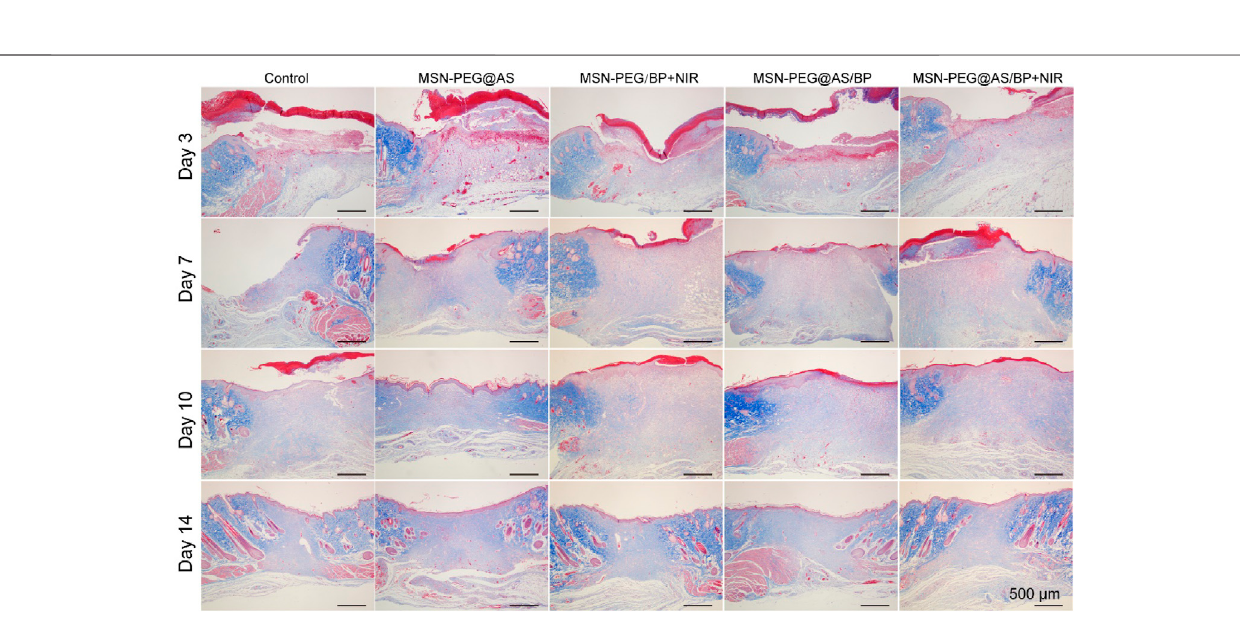
FIGURE 7 | Masson staining of wound sections at days 0, 3, 7, 10, and 14 with different treatments (Control, MSN-PEG@AS, MSN-PEG@BP + NIR, MSN-PEG@ AS/BP, and MSN-PEG@AS/BP +